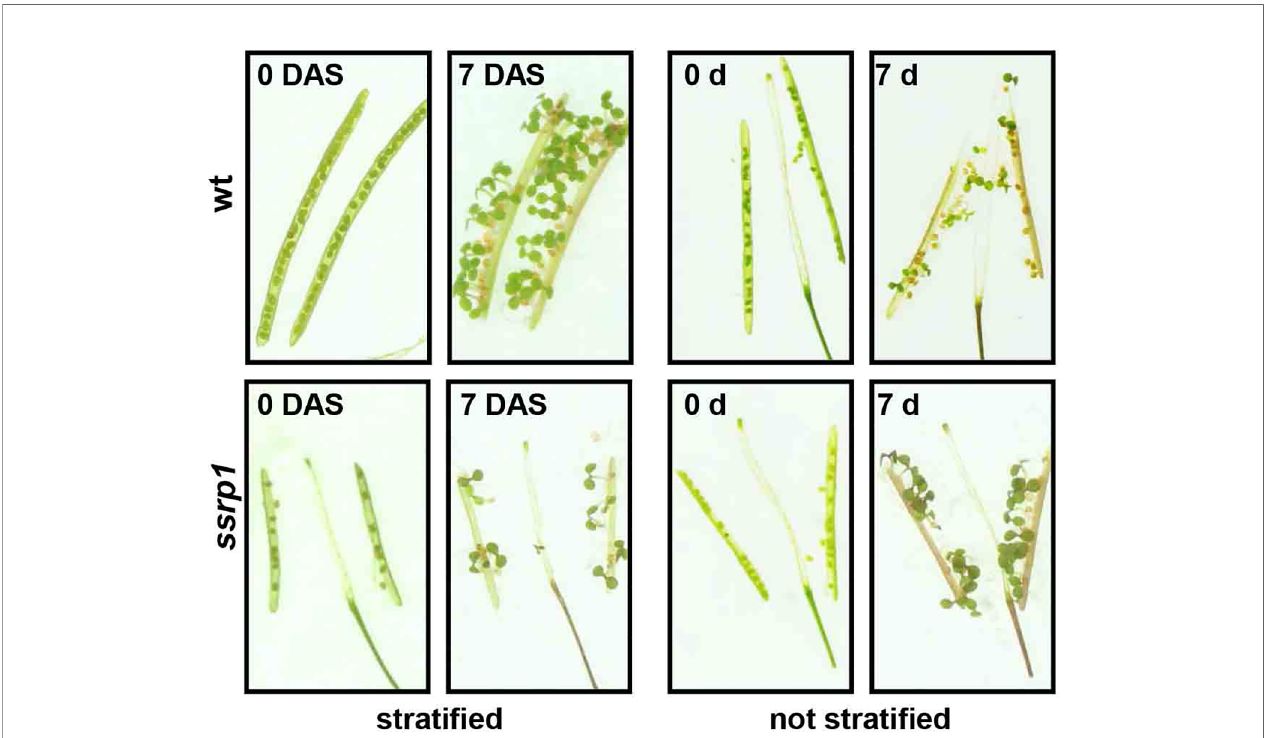
FIGURE 3 | Reduced dormancy of ssrp1 seeds. Germination assays with opened siliques harvested 14 days after fl owering. They are shown at day 0 and 7 days after incubation, either with or without prior strati fi cation. Note the smaller siliques of ssrp1 containing a severely reduced number of seeds compared to wt. After strati fi cation almost all seeds germinate, whereas without strati fi cation wt seeds germinate inef fi ciently (< 50%), whereas ssrp1 seeds due to reduced seed dormancy germinate ef fi ciently